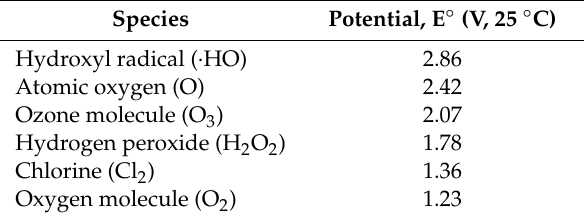
Table 1. Oxidation potential of some common oxidizing molecules and radicals [4].